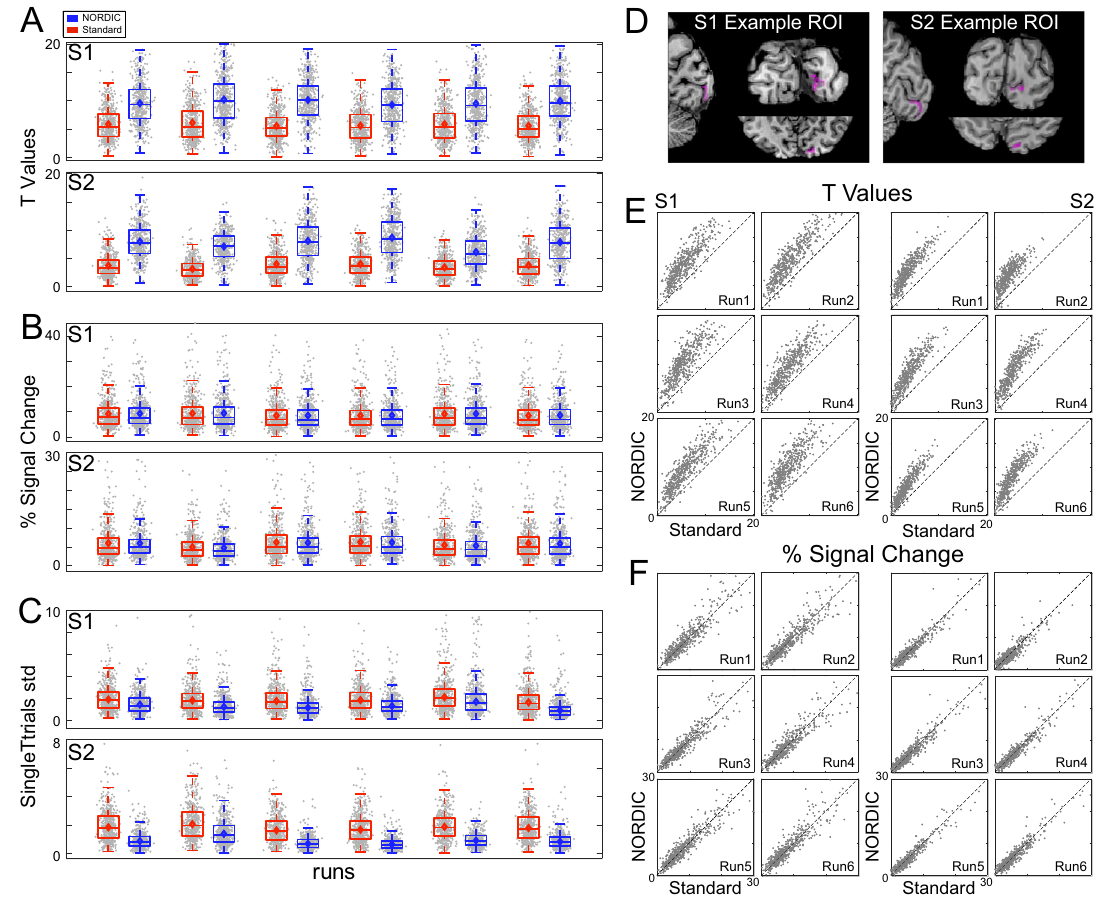
Fig. 3 Voxel responses within target ROI. Panel A shows the single-run (arranged over the x -axis) t -values (activity elicited by the target >0) induced by the target stimulus for Standard (red) and NORDIC (blue) data. Panel B is the same as panel A , but for beta weights (transformed into percent signal change). Panel C shows the single-run standard deviation computed across single-trial PSC beta estimates elicited by the target condition. For these three panels, gray dots represent responses to single voxels with the target ROI (497 for S1 and 461 for S2). The box-and-whisker plots, computed across all ROI voxels, represent the interquartile range (IQR — with box limits being the upper and lower quartiles), with the whiskers extending 1.5 times the IQR or to the largest value. The horizontal lines within the boxplot represent the median, while the diamond the mean across voxels. Panel D shows the target ROI, representing the left retinotopic representation of the target in V1 for 2 exemplar subjects in all three planes. Panel E shows the single runs, single-voxel scatterplots for t -values (activity elicited by the target > 0), for Standard ( x -axis), and NORDIC ( y -axis). Panel F : same as panel E for the beta percent signal change responses to the target condition. Source data are provided as source Data fi